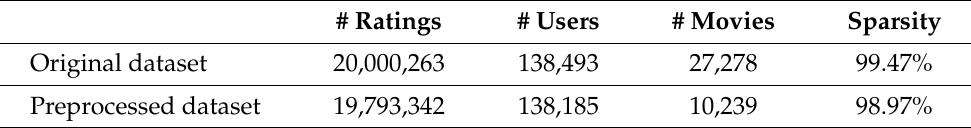
Table 1. Summary of the original MovieLens 20 M and the preprocessed